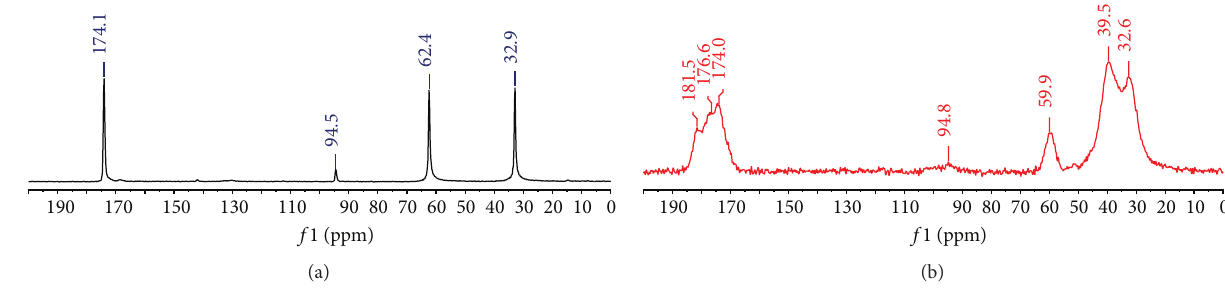
Figure 3: 13 C-NMR spectra of (a) PHP and (b) PAcHP obtained from bulk polymerization.